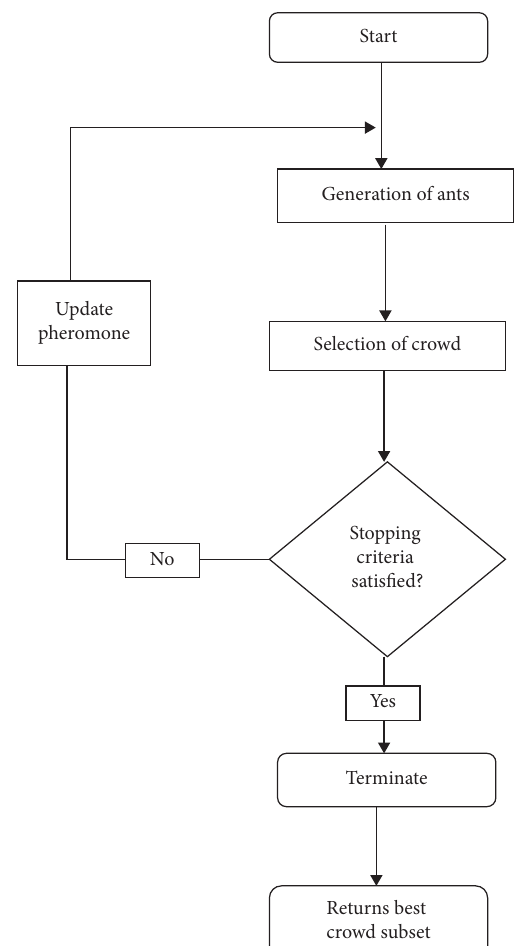
Figure 1: The proposed ant colony optimization-based crowd selection method